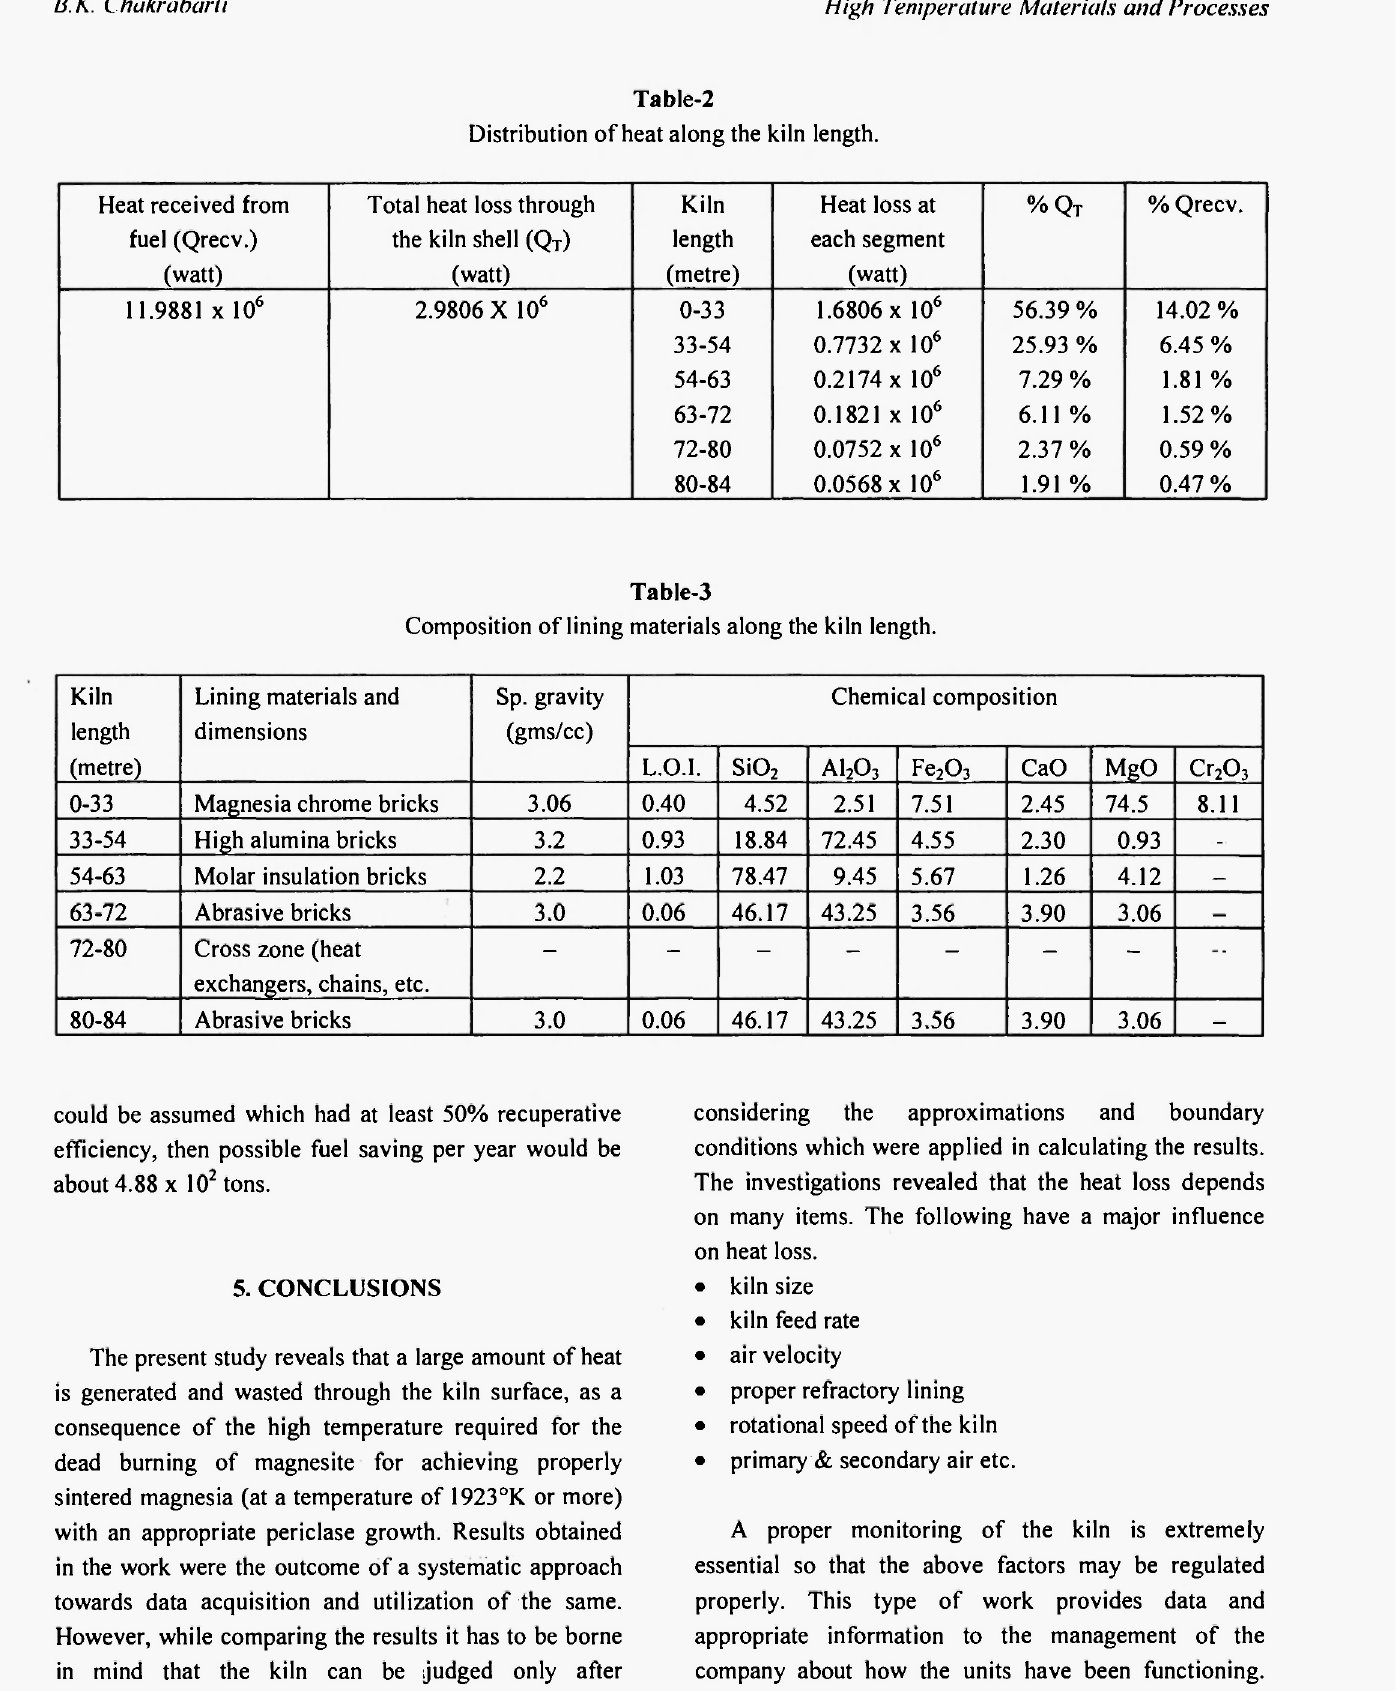
Composition of lining materials along the kiln length.